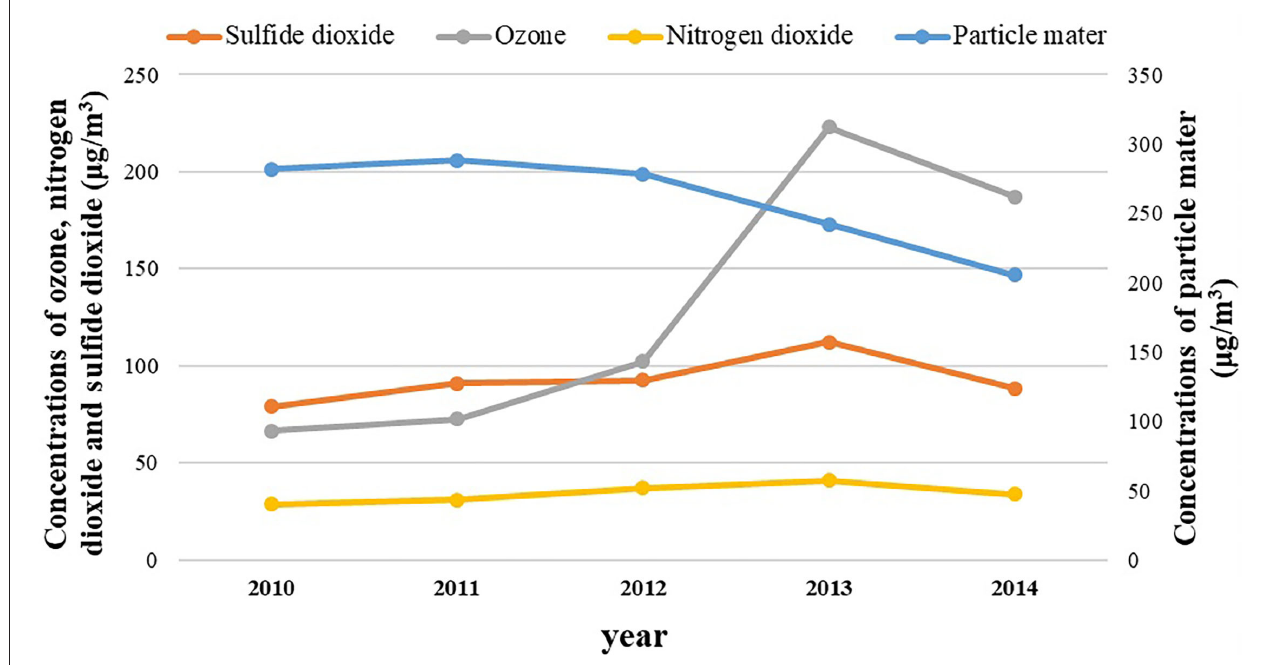
FIGURE 2 | Annual averages of the criteria air pollutants during the study period in ambient air of Ahvaz City, Iran.